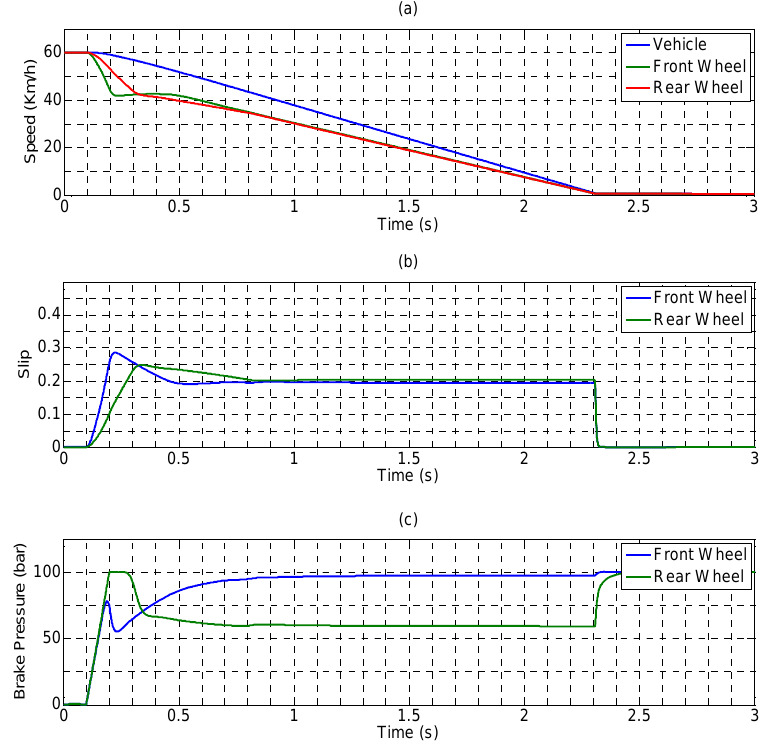
Figure 22. PEHB performing anti ‐ lock braking on a dry road surface: ( a ) vehicle speed and wheel speed; ( b ) slip; and ( c ) brake pressure.